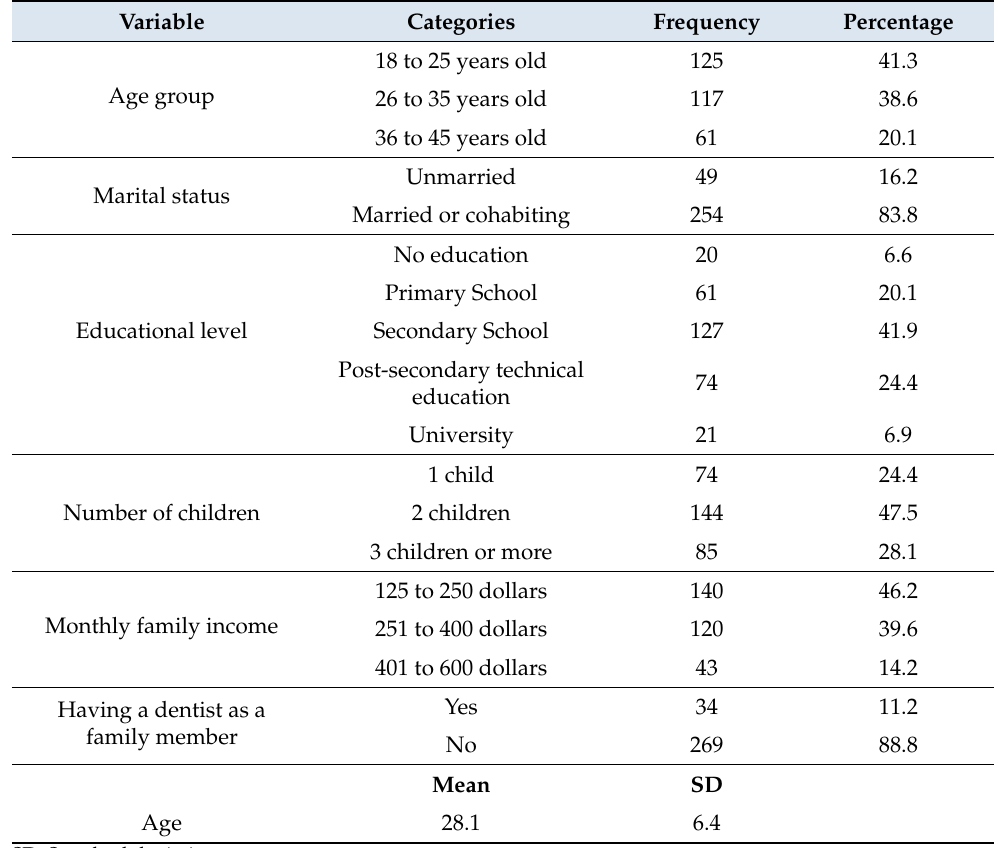
Table 1. Sociodemographic characteristics of early postpartum women belonging to the gynecology service of a Peruvian public